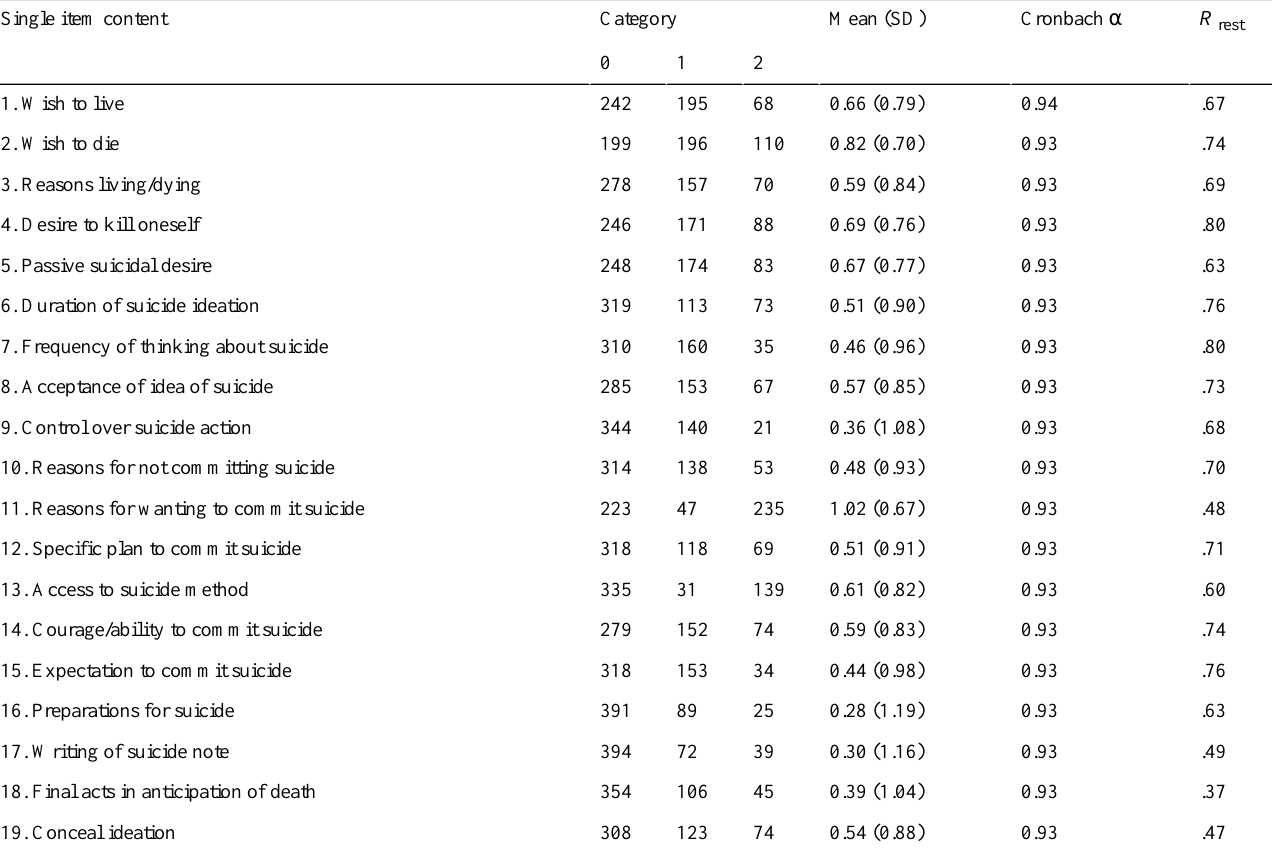
Table 1. Descriptive statistics of the single items of the